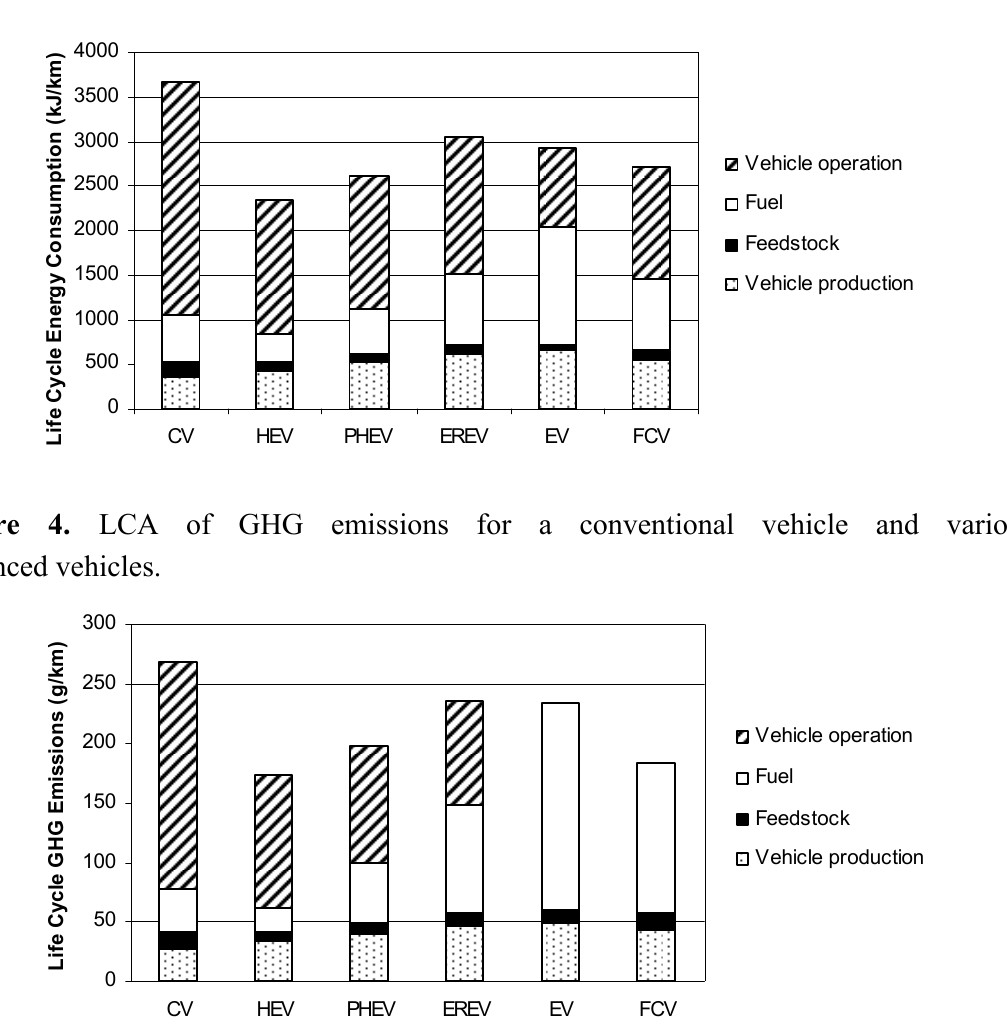
Figure 3. LCA of energy consumption for a conventional vehicle and various advanced vehicles.